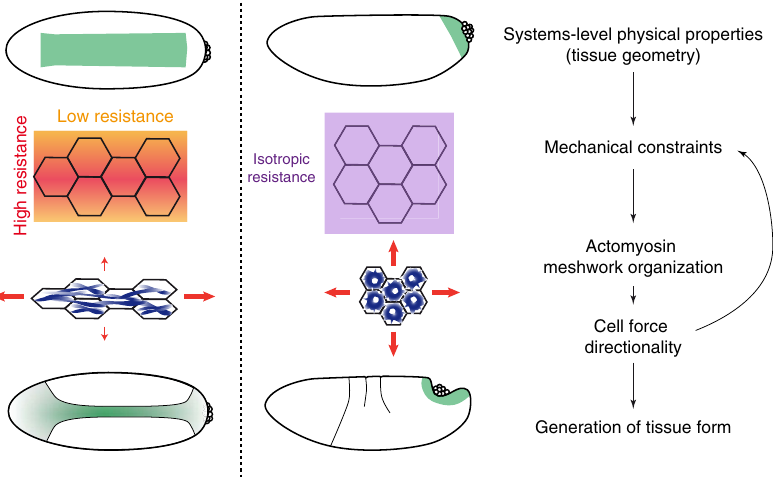
Figure 7 | Model: tissue shape orients actomyosin meshworks and tension to generate specific tissue forms. Tissue shape and geometry impose mechanical constraints to deformation. For example, the rectangular shape of the VF means that more cells generate tension (red arrows) and resist constriction along the long a-p axis than the short d-v axis, whereas the more isotropic domain of the presumptive PMG imposes isotropic constraints. Actomyosin meshworks sense and respond to these constraints by adopting different configurations (that is, rings or fibres). The meshwork configuration, in turn, could orient cell force generation. The combination of tissue geometry and cell force directionality then governs the final tissue